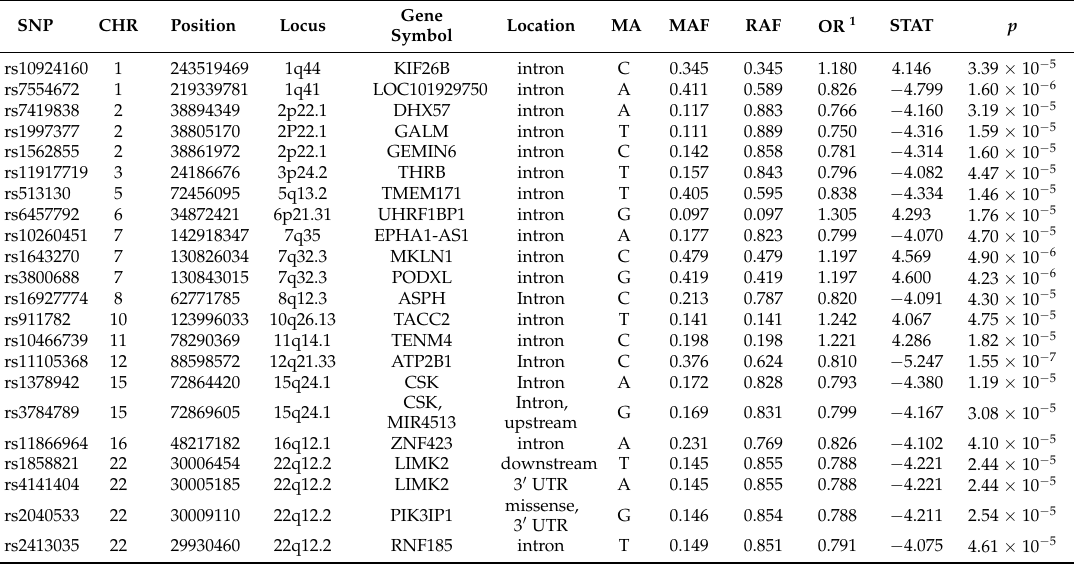
Table 1. Description of tagging SNPs including interaction analysis in sample 1.